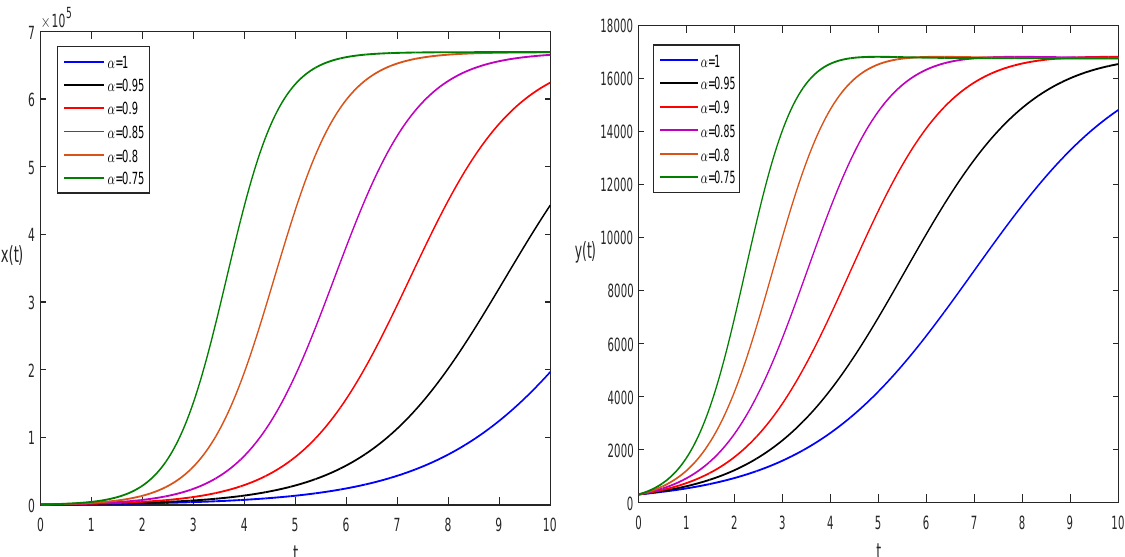
Figure 3. Comparison of the solutions of both the systems given in Equations (1) and (2).